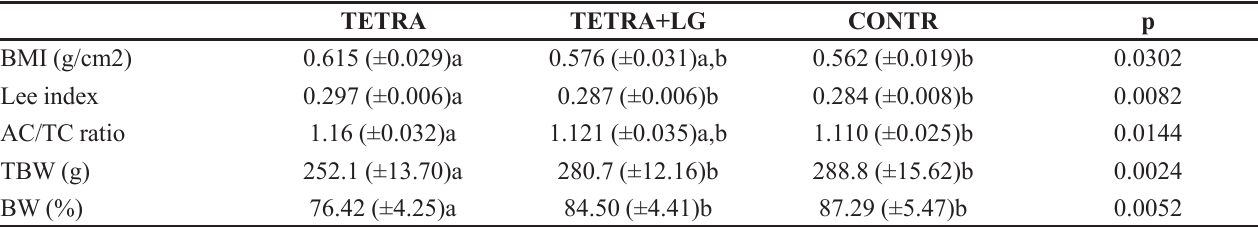
BMI – Body Mass Index; AC/TC ratio – Abdominal Circumference / Thoracic Circumference Ratio; TBW (g) – Total body water in grams; BW (%) – Percentage of body water; TETRA – Tetracycline group (75 mg/kg/day); TETRA+LG – Tetracycline plus L.gasseri group (75 mg/kg/day plus 10 9 cfu); CONTR – Control group; Different superscripted letters, in same row, indicate statistical significance p